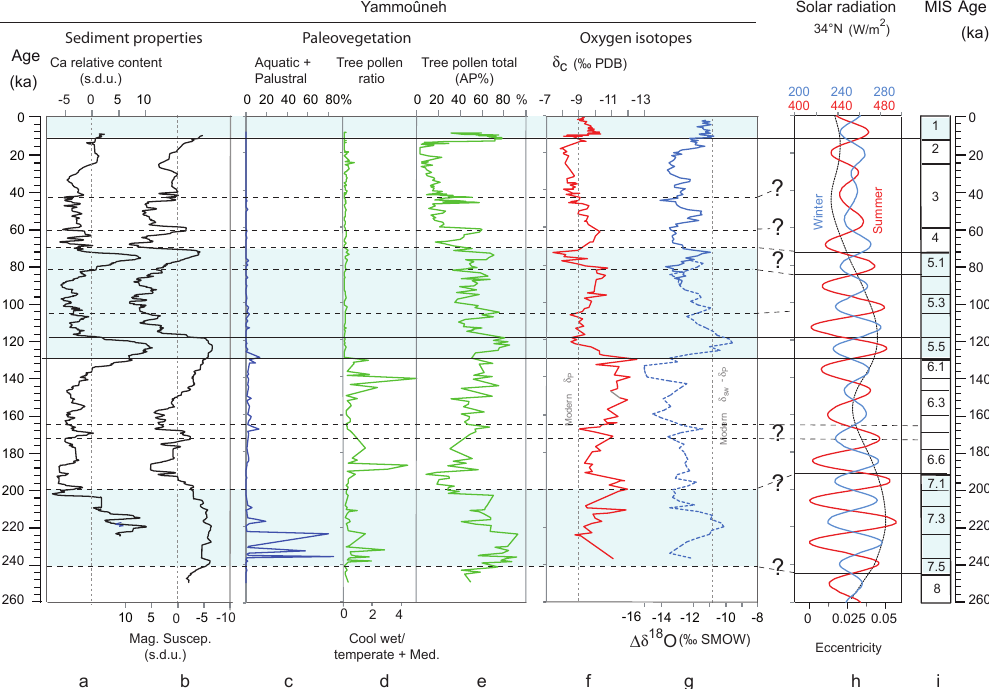
Fig. 10. Major proxies from Yammoˆuneh versus time according to our age model, and external paleoclimate data (on independent time scale). (a) Ca relative content. (b) Magnetic susceptibility. For clarity, these two proxies are plotted as the first component factor of a Singular Spectrum Analysis (performed using the Paillard et al., 1996, software) and representing 84 and 92.3% of the total variance, respectively (s.d.u.: standard deviation units). (c) Aquatic+palustral plant pollen (percentage of total pollen grains). (d) Ratio of the pollen percentages (percentage of terrestrial pollen) of cool conifer forests/temperate to Mediterranean forests. (e) Total tree pollen percentages. (f) δ c . (g) 1δ 18 O (as in Fig. 7f). (h) Orbital eccentricity and summer/winter insolation at 34 ◦ N (Berger, 1978); (i) MISs (Martinson et al., 1987). Questions marks between (g) and (h) suggest links between major environmental changes at Yammoˆuneh and global climate changes.